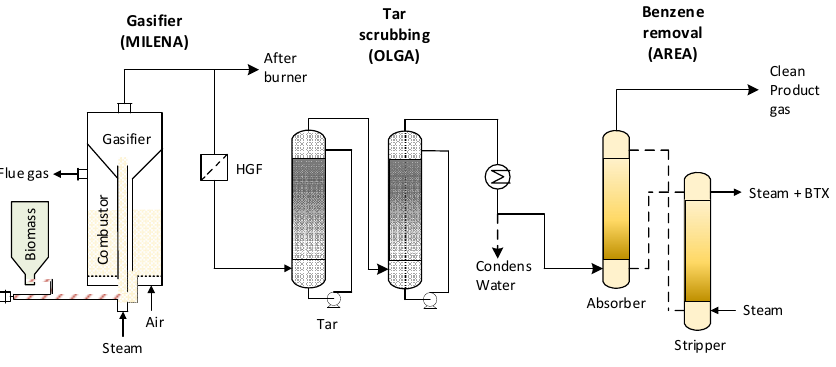
Figure 2. Process flow diagram of the experimental setup.